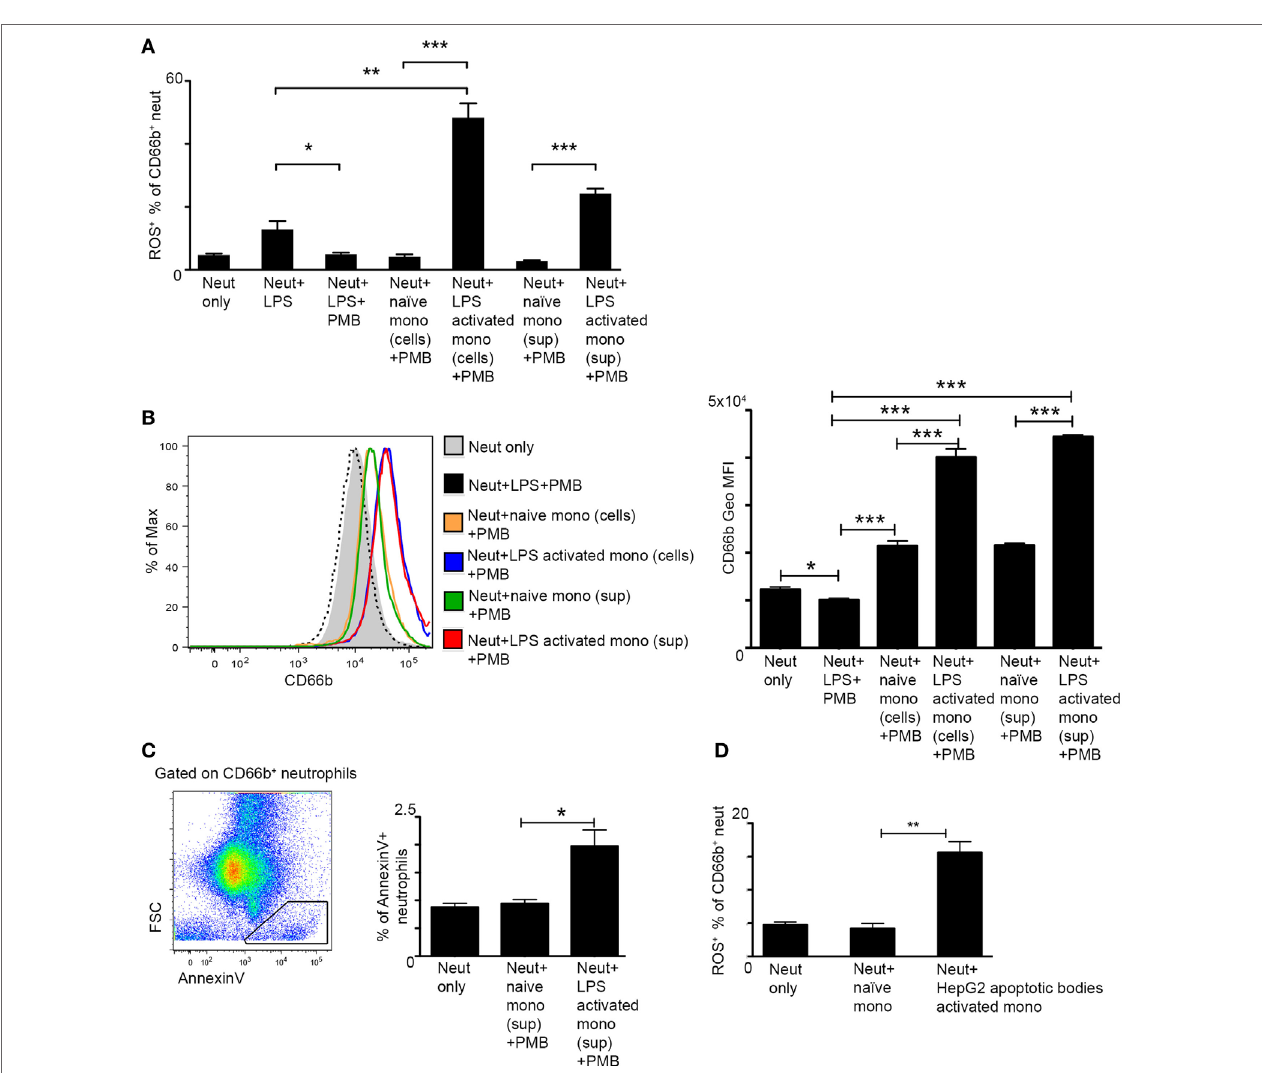
FigUre 4 | activated monocytes directly induce reactive oxygen species (rOs) production by neutrophils . (a) Graphical summary of flow cytometry analyses showing the fraction of ROS + neutrophils out of CD66b + neutrophils following 2 h culture with lipopolysaccharide (LPS)-activated human CD14 + monocyte cells or with their cell-free supernatants; Polymyxin B (PMB) was added to all cultures in order to avoid direct activation of neutrophils by LPS remnants. (B) Left, representative histogram plot showing the expression level of the neutrophil activation marker CD66b following different treatments. Right, Summarizing graph showing the geometric mean fluorescence intensity (Geo MFI) of CD66b protein following different treatments. (c) Left, representative flow cytometry image showing the identification of AnnexinV + FSC lo apoptotic cells among CD66b + neutrophils. Right, Summarizing graph showing the fraction (%) of these cells among total CD66b + neutrophils. (D) The fraction of ROS + neutrophils out of CD66b + neutrophils following 2 h culture with human CD14 + monocyte cells pre-activated with HepG2 apoptotic bodies. Data were analyzed by unpaired, two-tailed t -test and are presented as mean ± SEM with significance: * p < 0.05, ** p < 0.01, *** p < 0.001 ( n ≥ 3 human donors/group for each monocyte group, the same pool of neutrophils was